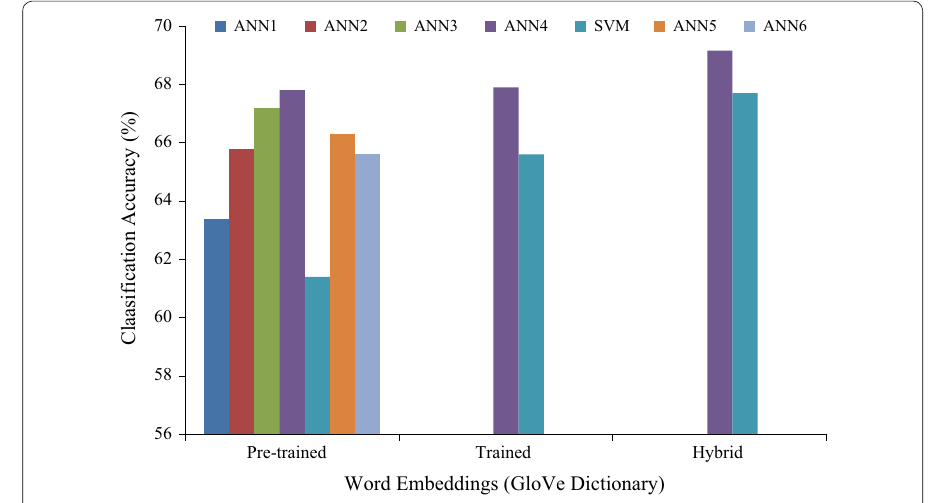
Fig. 3 Performance of SVM and ANN models for different word embeddings